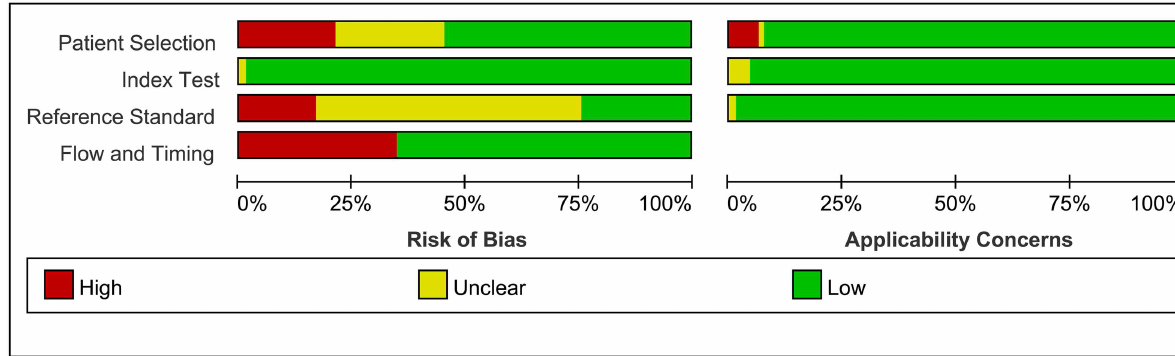
Fig 2. Results of QUADAS-2, Risk of bias and concerns regarding